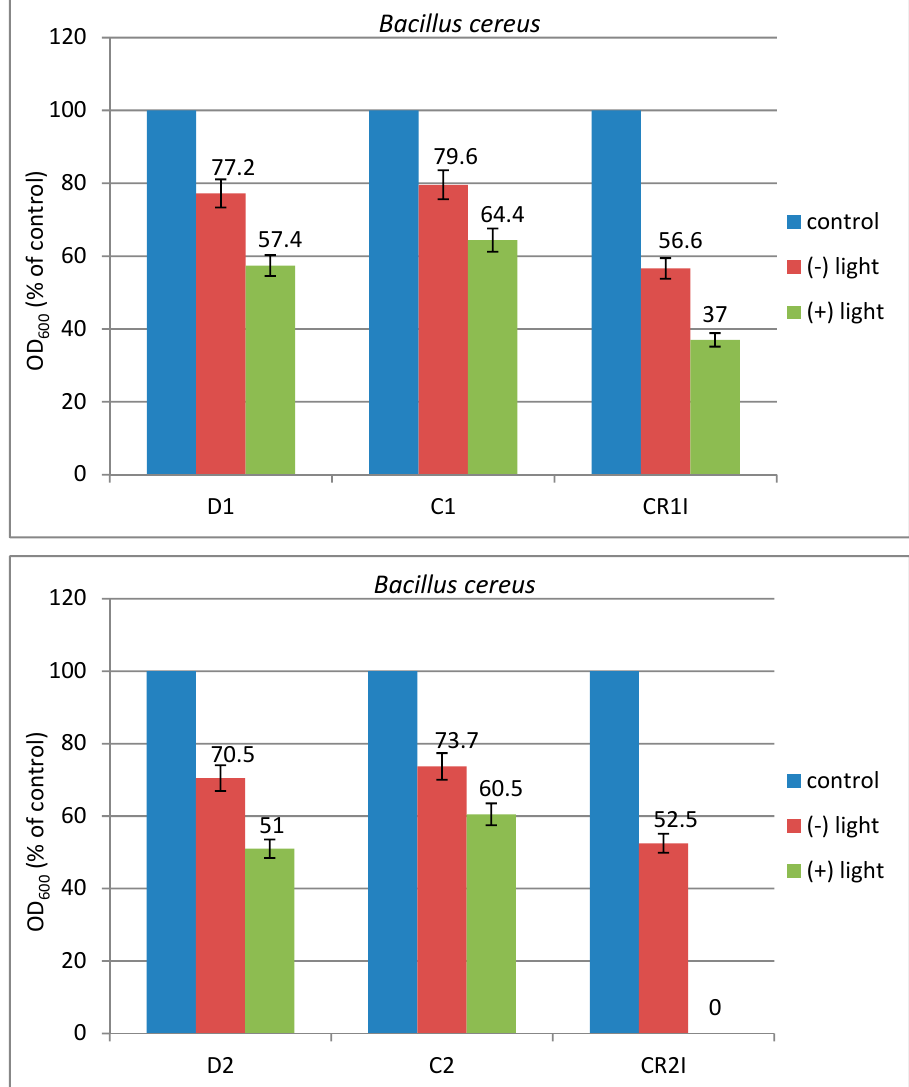
Figure 9. Antimicrobial activity of the textile samples D1, C1, CR1I , D2, C2, and CR2I, in the dark and after illumination with visible light.